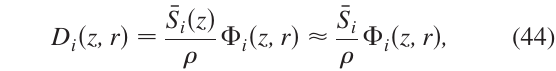
FIG. 1. Comparison of analytical (solid curves) and MC (his- togram curves) depth variation of the broad beam, (cid:3) ð z Þ [Eq. (28)] and the fluence incident of cylindrical targets (cid:3) ð z; j r j (cid:8) R Þ [Eq. (27)] as well as the broad beam absorbed dose, D ð z Þ [17] and the narrow beam absorbed dose D ð z; R Þ [Eq. (29)] of primary 7 Li ions in a 234 MeV = u beam in water. The dotted lines are the primary absorbed dose, analytically calculated, divided into its low ( < 10 eV = nm ) and high ( > 20 eV = nm ) LET components. The results have been normalized to the primary values at the phantom surface. The point monodirectional pencil beam data are evaluated inside cylindrical shells with radii of 0–0.5 mm and 0.5–1.0 mm. The loss of primaries and the enhanced scattering events result in a significant reduction of the fluence and absorbed dose value close to the central axis. Interestingly, the true central axis fluence is considerably higher as indicated by the dash- dotted lines reaching a value about 25 at the